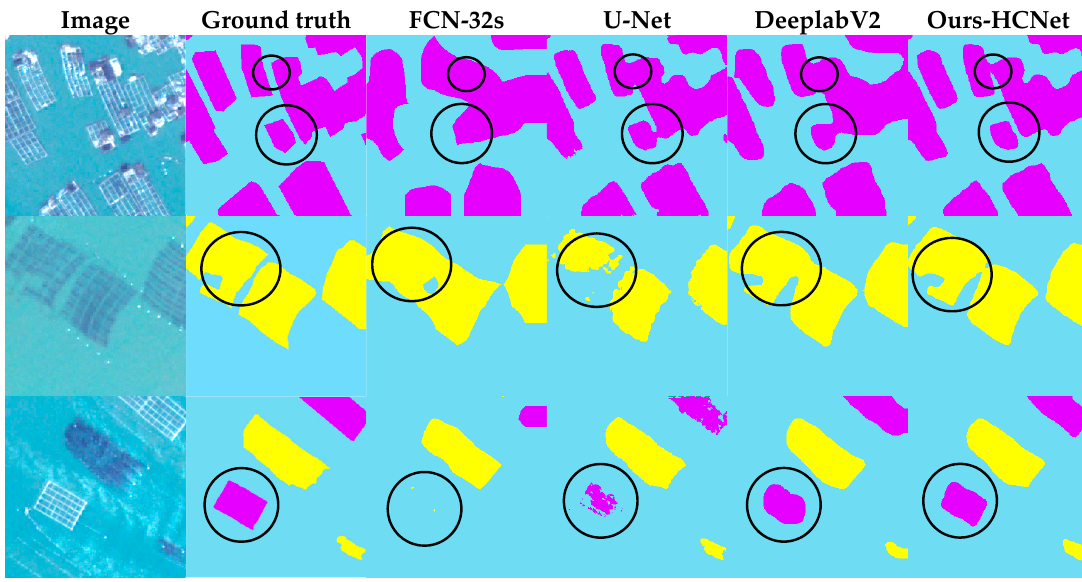
Figure 7. The classification results of CCA and RCA by using our proposed method and other comparison methods. The black circles indicate that our proposed HCNet obtains the best performance.